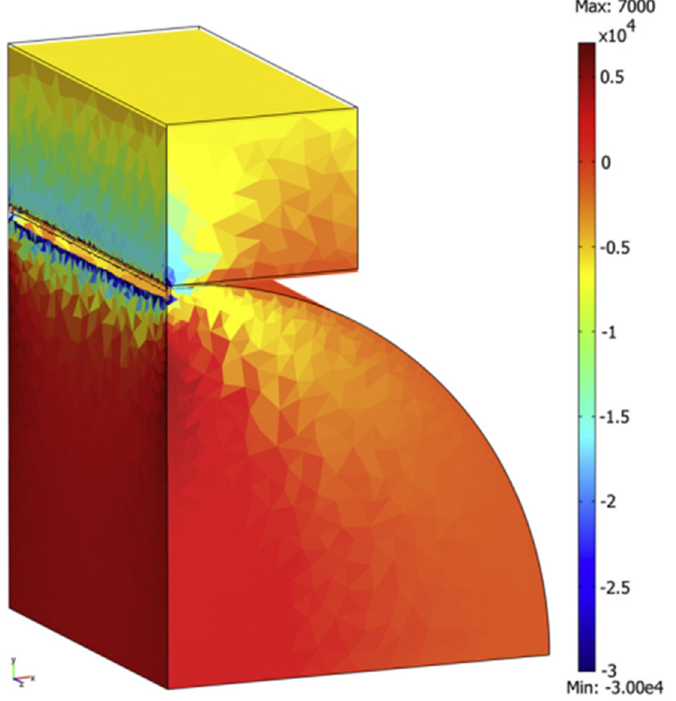
Figure 7. 3D model of circular tablet under compression showing positive and negative tensile stress in the x direction. Reprinted with permission from Ref.